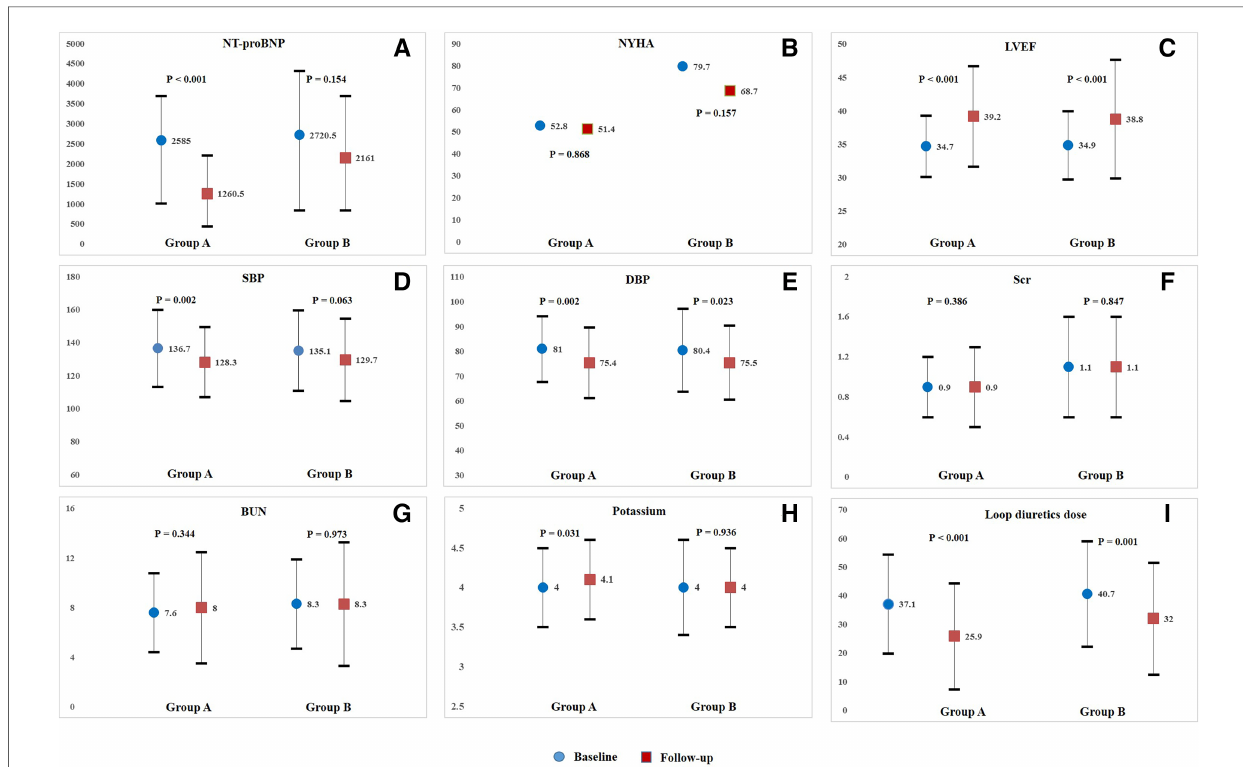
FIGURE 1 Intra-group comparisons of NT-proBNP( A ), NYHA class ( B ), LVEF( C ), SBP( D ), DBP( E ), Scr( F ), BUN( G ), potassium( H ), and loop diuretics dose( I ), from baseline to follow-up in Group A or Group B. NT-proBNP, N-terminal pro-B-type natriuretic peptide; NYHA, New York Heart Association; LVEF, left ventricular ejection fraction; SBP, systolic blood pressure; DBP, diastolic blood pressure; Scr, serum creatinine; BUN, blood urea